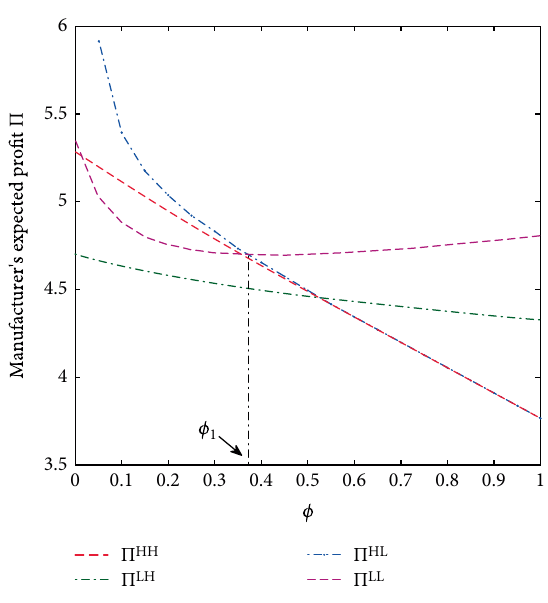
Figure 8: Impact of 𝜙 on Π